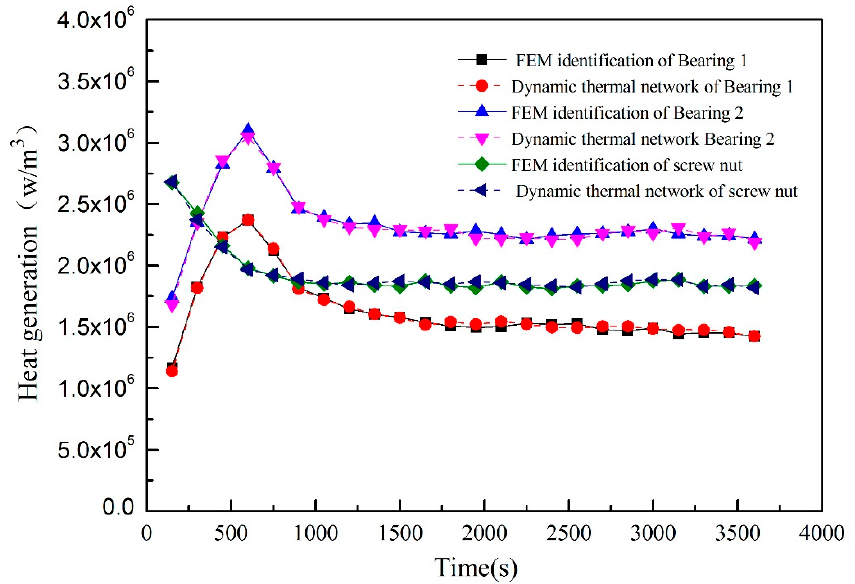
Figure 11. Heat generation of the heat sources identified by different calculation method.